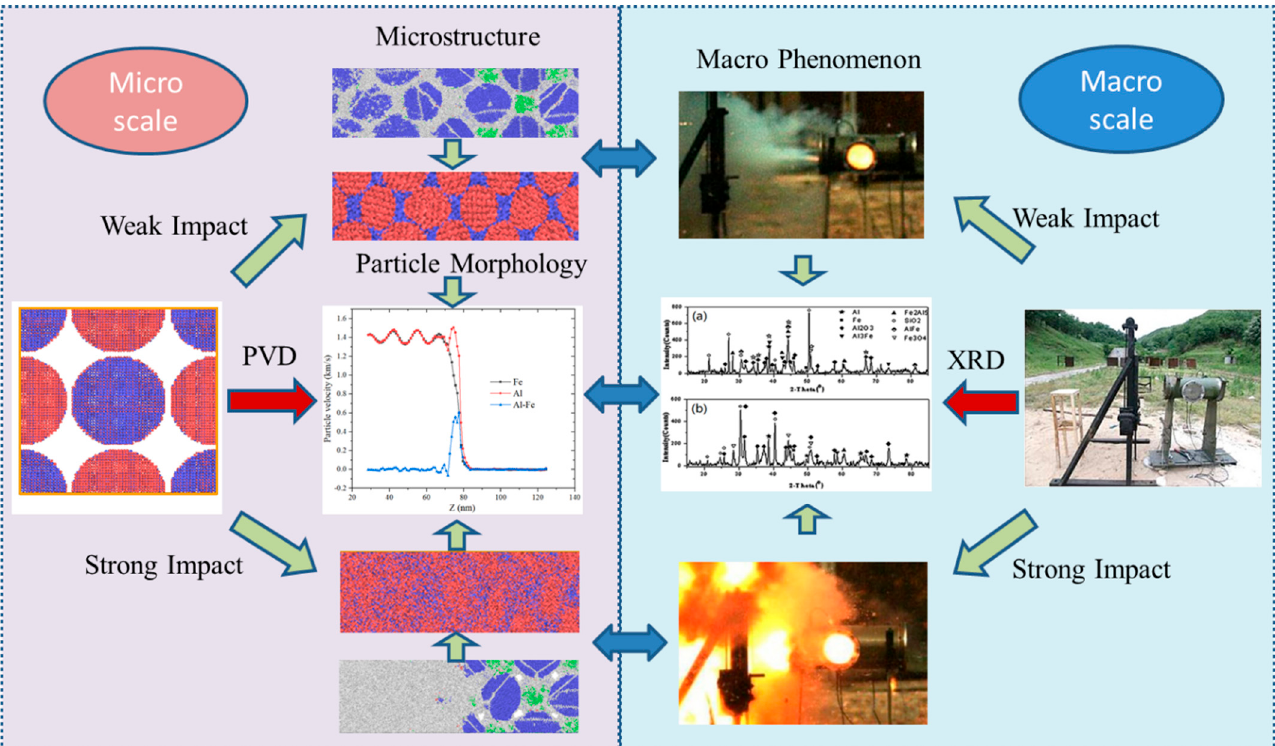
Figure 19. Mechanism of Fe–Al energetic jet induced reaction.